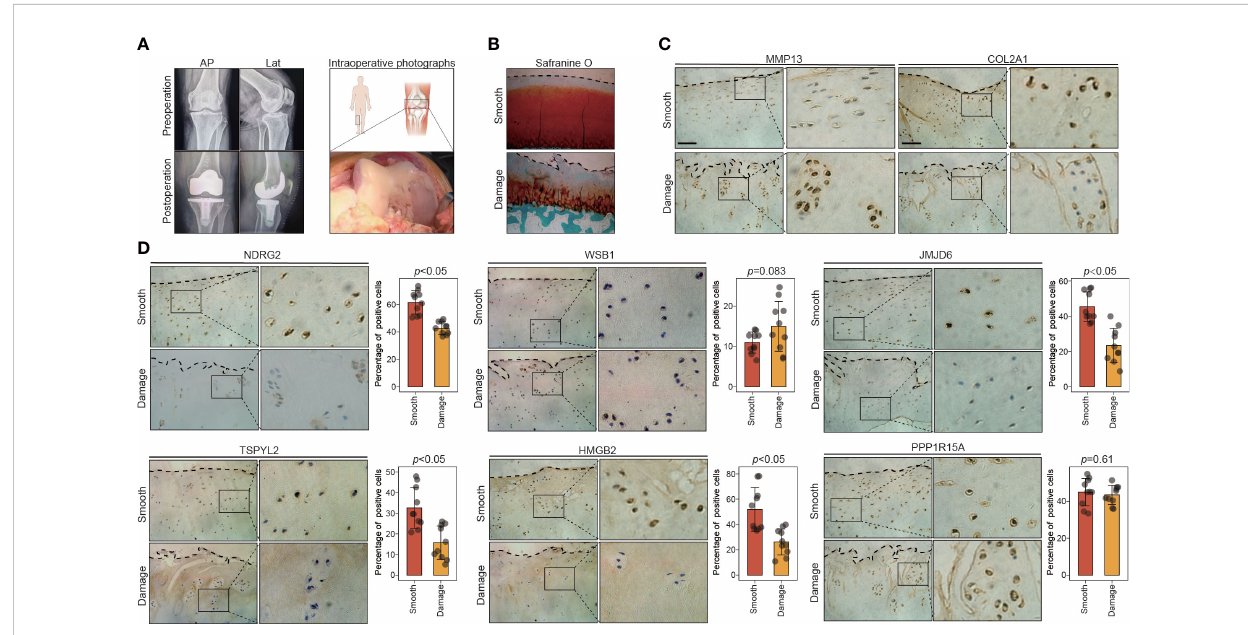
FIGURE 5 The expression of key leading-edge proteins in the human knee cartilage samples. (A) Representative X-rays and intraoperative photographs of clinical cartilage samples (n=10). (B) Representative images of safranin O/fast green staining in smooth and damaged cartilage from human knee joints. (C) Representative images of immunohistochemical staining with antibodies against MMP13 and COL2A1 in smooth and damaged cartilage from human knee. (D) Representative images of immunohistochemical staining with antibodies against NDRG2, WSB1, JMJD6, TSPYL2, HMGB2 and PPP1R15A in smooth and damaged cartilage from human knee. The right panels show the quanti fi cation of the immunohistochemical staining. The scale bar represents 50 m m. AP, Anteroposterior; Lat, lateral; S, smooth cartilage; D, damaged cartilage. All data are expressed as the mean ± SD. Student ’ s t test was used for statistical analysis. p < 0.05 was considered statistically signi fi